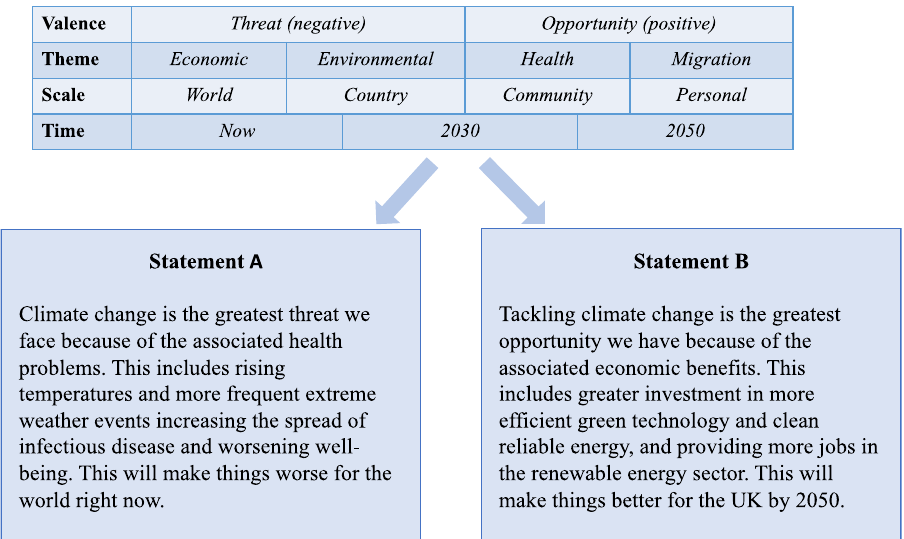
Fig. 4 List of attributes and frames, and examples of randomly generated paired statements. Table at the top contains the four different attributes (left column) to create the statements — valence, theme, scale, and time frame — using random assignment of the different levels within each (rows). This makes a total of 96 possible permutations, i.e., different statements. Respondents were shown two randomly generated statements and were asked to indicate which of the two statements would make them more likely to support policies to tackle climate change. Statement A and B show two example statements. Note that all statements have contextually appropriate examples added to them in addition to just the four attributes to help respondents understand the